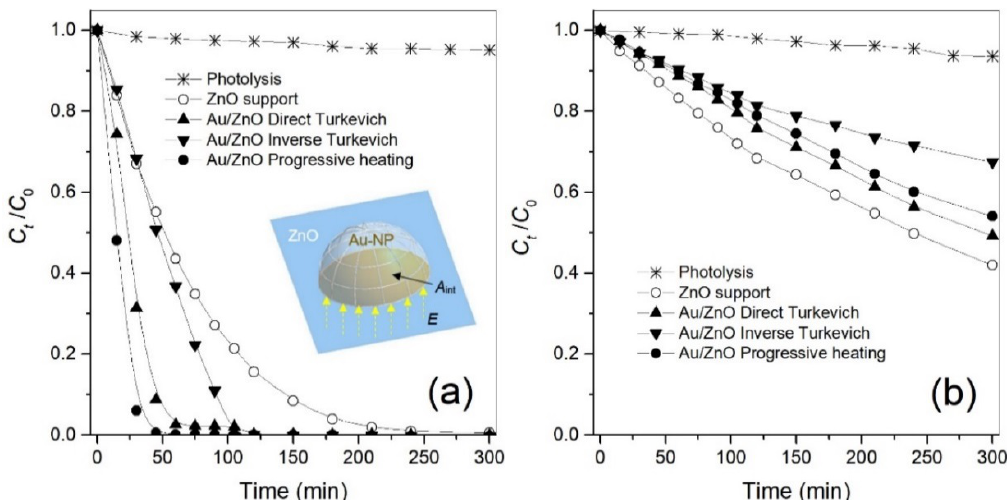
Figure 7. RhB decolorization curves using the synthesized photocatalysts activated by the ( a ) UV-lamp and ( b ) sunlight-LED. C t : RhB concentration at the time t ; C 0 : initial RhB concentration. Inset :